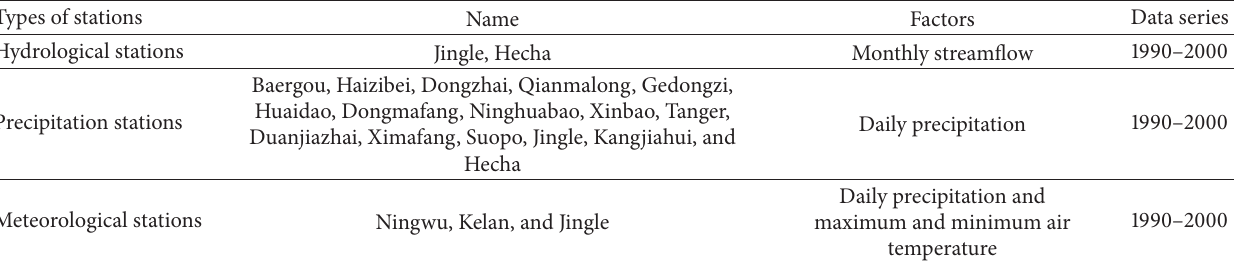
Table 1: Hydrometeorological stations in the study area.